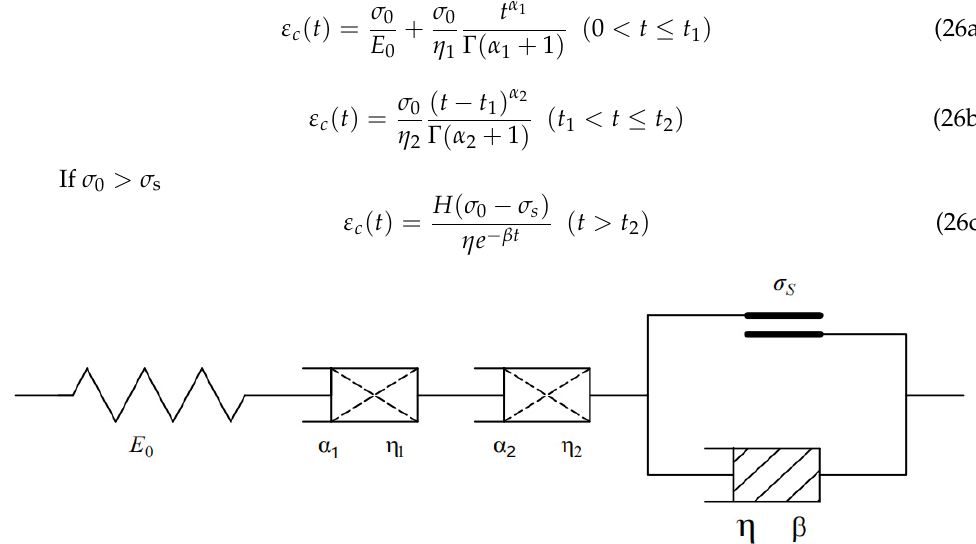
Figure 11. Improved variable-order fractional creep constitutive model.